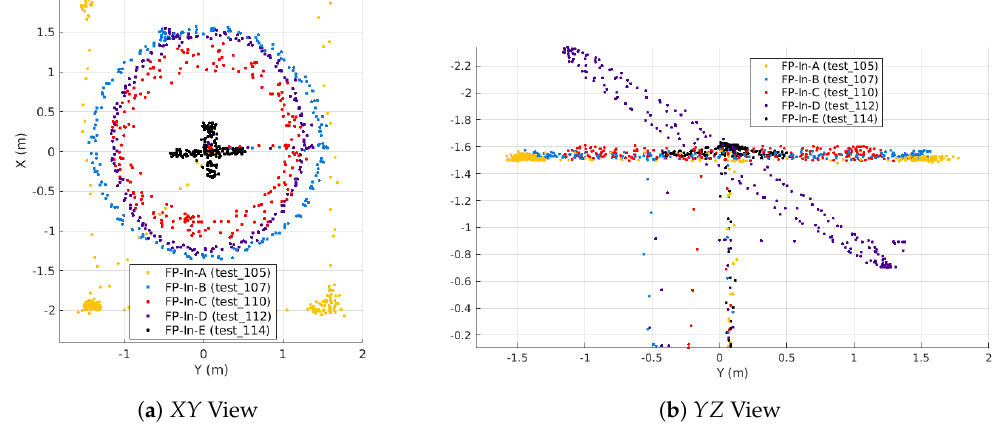
Figure 5. Five indoor flight